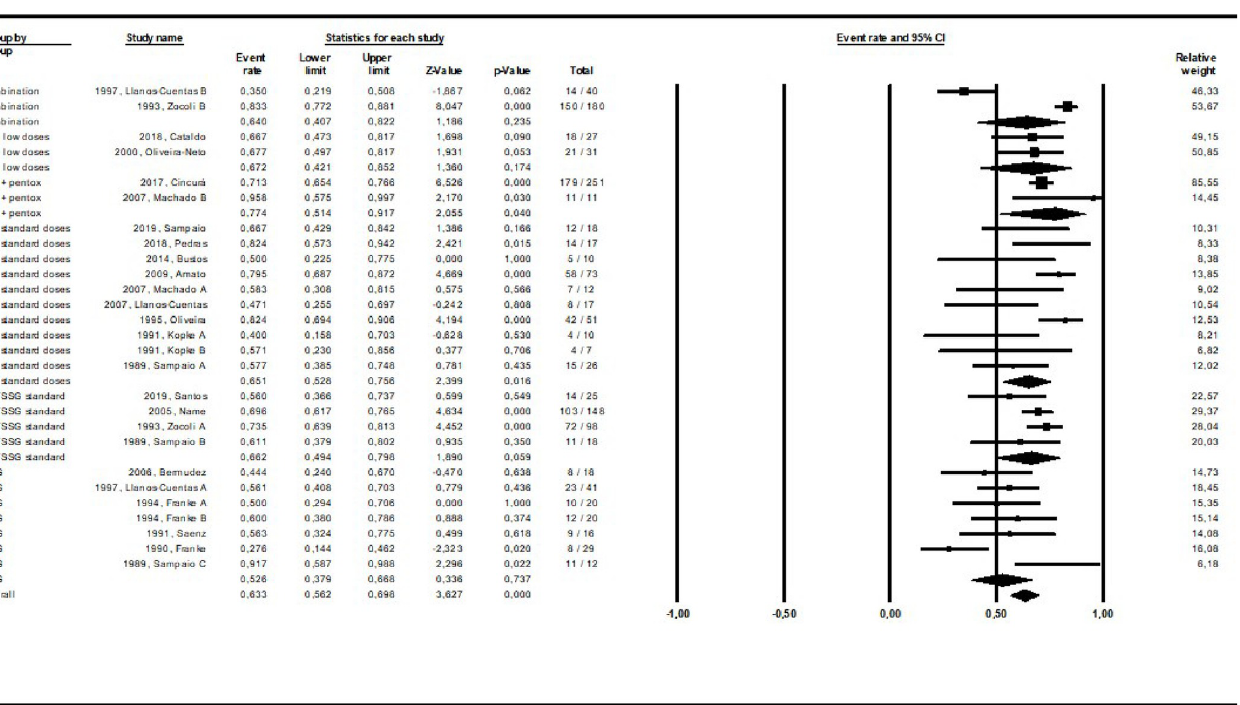
Fig 2. Pooled cure rate of pentavalent antimonials using a mixed effects analysis. MA: Meglumine antimonate. Pentox : pentoxifylline. SSG : Sodium stibogluconate. Different interventions in the same study were indicated by letters.